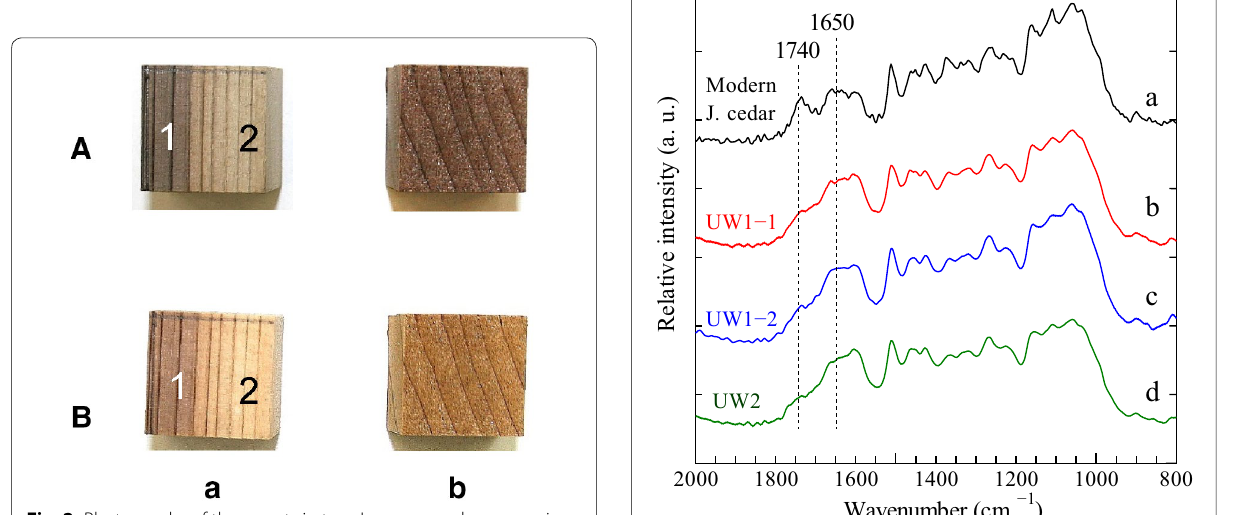
Fig. 2 Photographs of three parts in two Japanese cedar umoregi wood samples before and after treatment with oxalic acid solution. A Samples before treatment; (a-1) UW1-1, (a-2) UW1-2, and (b) UW2. B Samples after treatment; (a-1) UW1-1, (a-2) UW1-2, and (b) UW2.